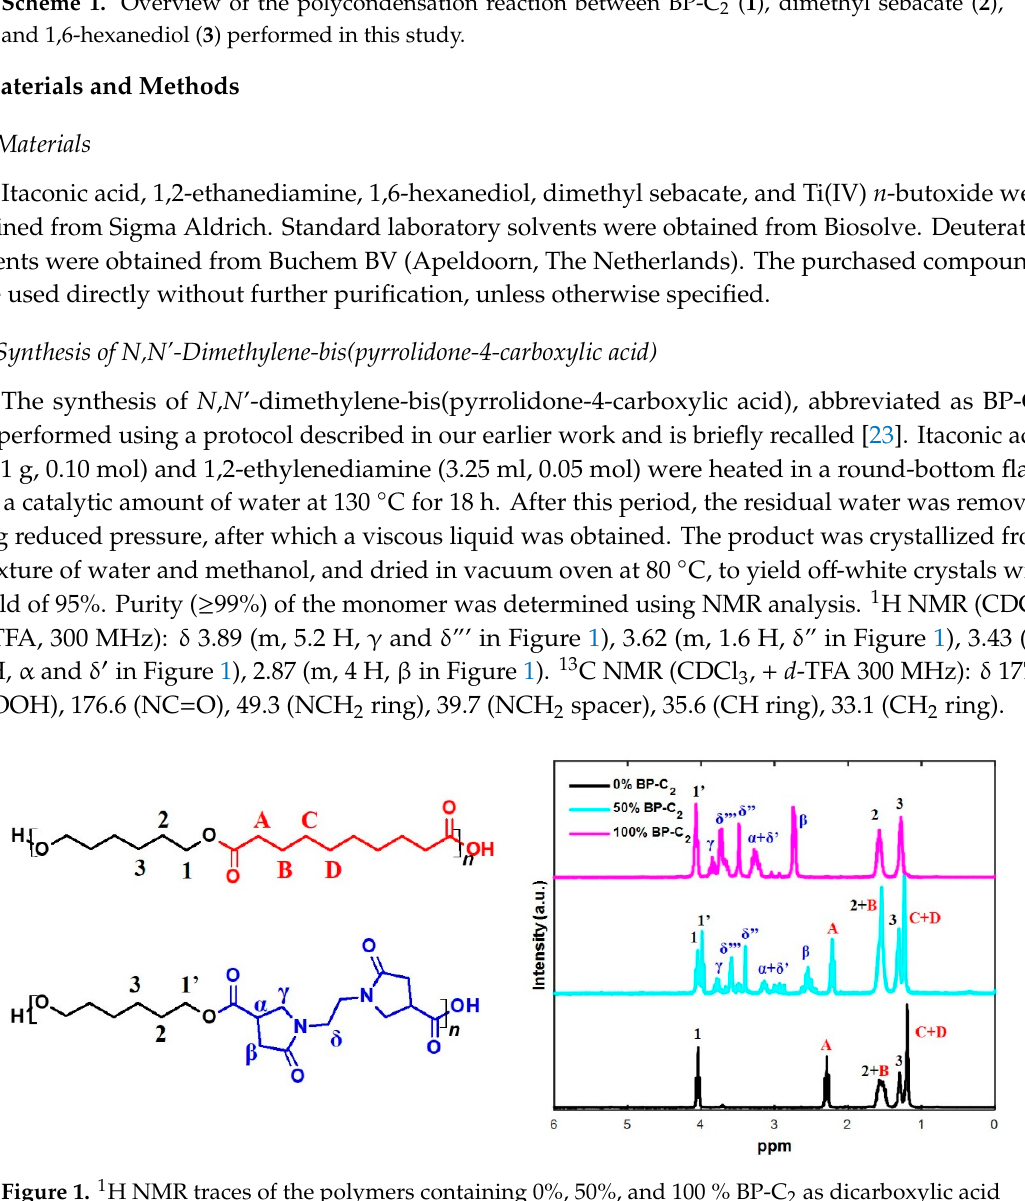
Figure 1. 1 H NMR traces of the polymers containing 0%, 50%, and 100 % BP-C 2 as dicarboxylic acid together with the denotation of protons.